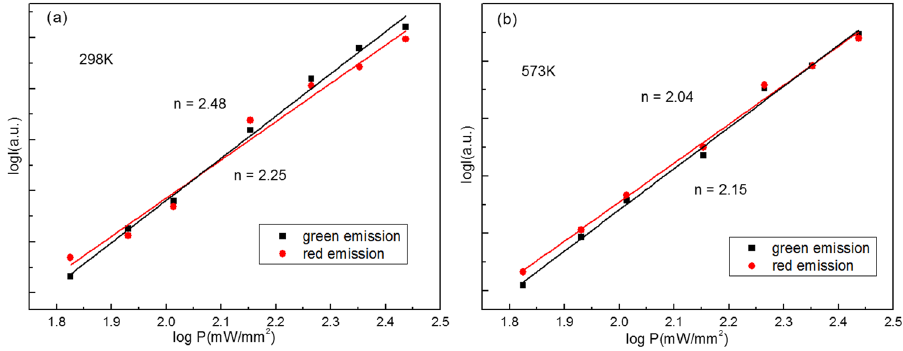
Figure 8. Log-log plots of emission intensity and pumping power for Y 2 O 3 :1%Er 3 + , 0.2%Tm 3 + at ( a ) 298 K and ( b ) 573 K.